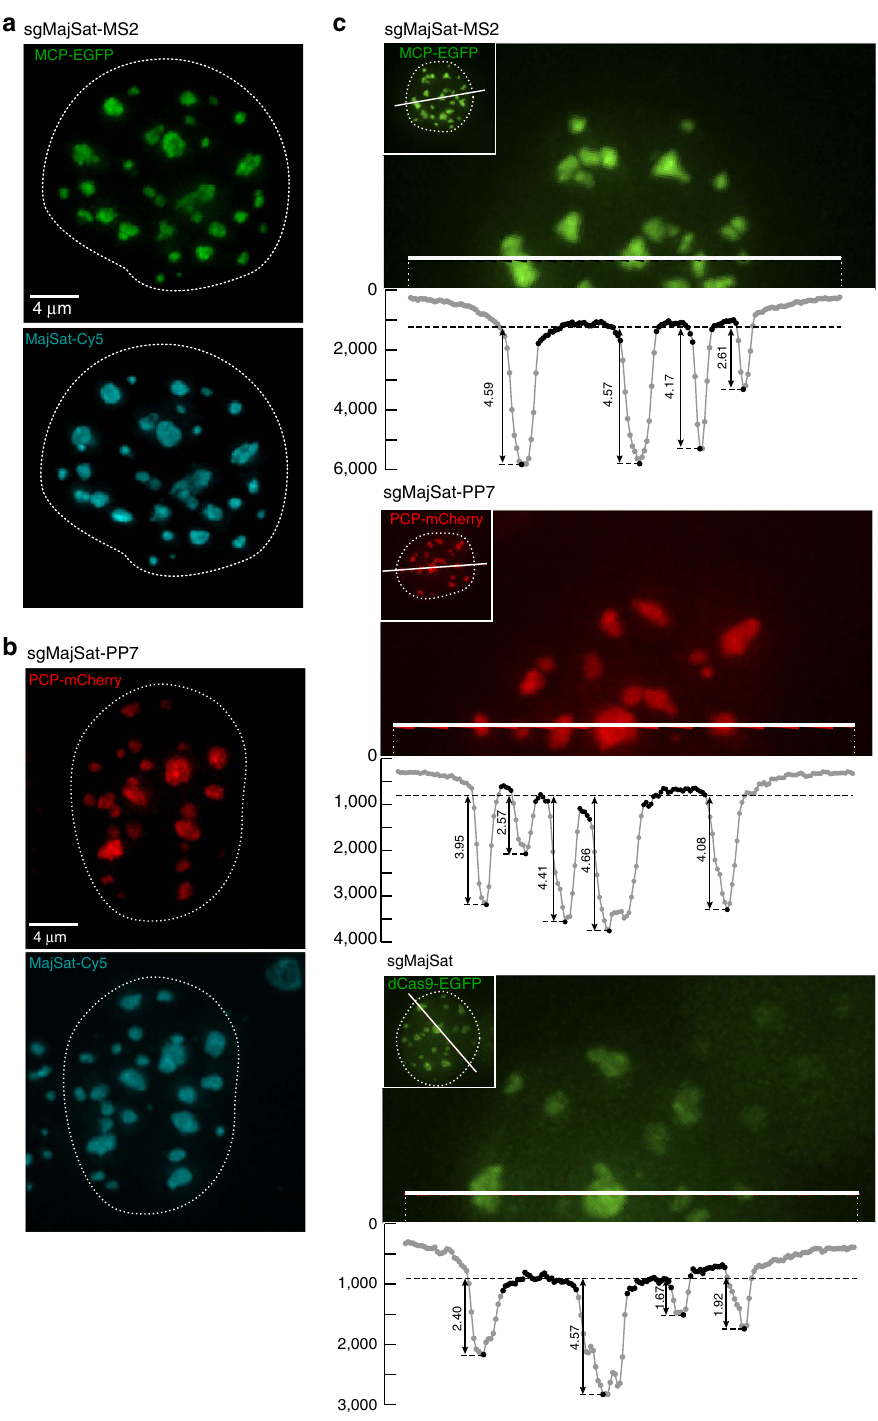
Figure 2 | Chimaeric sgRNAs allow recruitment of fluorescent proteins and efficient labelling of major satellites. ( a , b ) Expression of either sgMajSat-MS2 or sgMajSat-PP7 sgRNAs in cells expressing dCas9, MCP-EGFP and PCP-mCherry leads to efficient labelling of pericentromeric regions in green or red, respectively (top panels). Fluorescent protein signals were validated using FISH with a g -satellite probe (bottom panels). ( c ) The signal obtained with sgRNAs was compared with dCas9-EGFP fusion protein signal. Signal to background ratio was measured from raw images. The long dashed line across the entire plot represents the averaged intensity of background. The short dashed lines indicate the highest value of each peak, which is the highest intensity of each PCH punctum. Values next to vertical arrows represent the signal-to-background